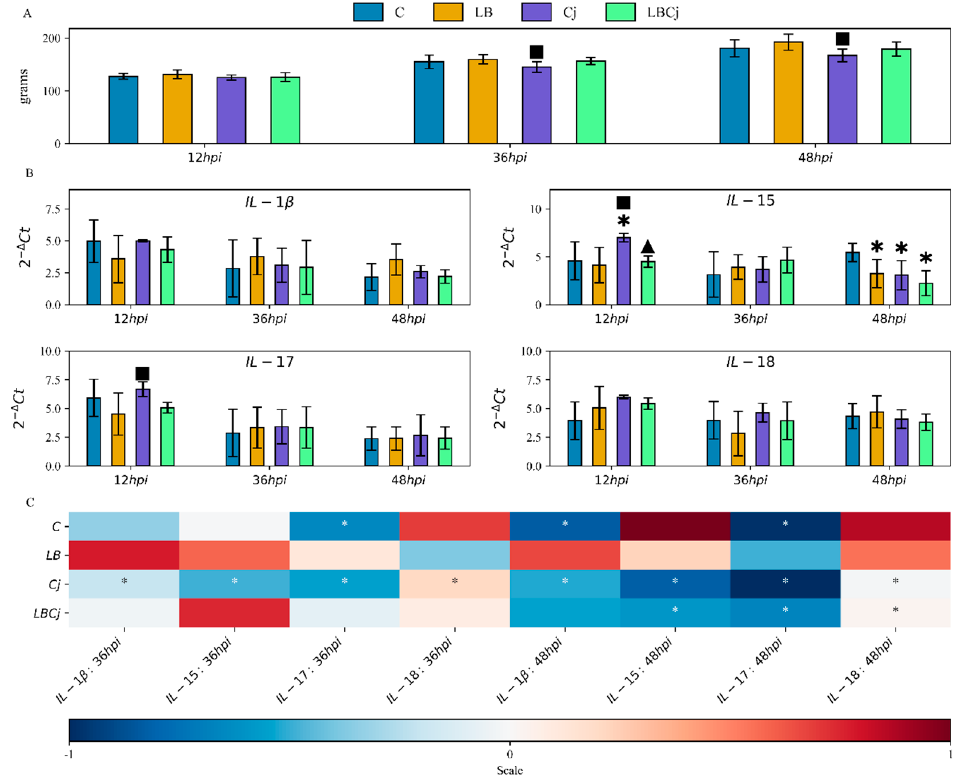
Figure 1. Effects on body weight and pro-inflammatory cytokine expression of L. fermentum and C. jejuni colonization at three different stages. (A) Average body weights of treated and untreated animals at 12, 36 and 48 hpi. (B) mRNA expression levels of caecal pro-inflammatory cytokines at three different time points. The Ct values of studied genes were normalized to a Ct value of the reference gene (GAPDH) (Delta - Δ - Ct), and calculated as 2 – Δ Ct. Values are mean ± standard error SE ( n = 9). * denotes significant differences (Tukey’s test, p < 0.05) with the control group; ■ with the L. fermentum treatment, ▲ with C. jejuni treatment. C, control group; LB, L. fermentum group; Cj, C. jejuni group; LBcj, co-exposure group; hpi, hour post-infection. (C) Heat map denoting transcriptional fold change between time points. The colour scale, − 1 (blue) to + 1 (red), denotes mRNA levels relative to the values of the control group, with white designating down-regulated genes and black designating up-regulated genes. Relative expression was calculated and expressed as 2 – ΔΔ Ct log 2 fold change. Values are mean ± SE ( n = 9). * denotes significant differences (Tukey’s test, p < 0.05). C, control group; LB, L. fermentum group; Cj, C. jejuni group; LBcj, co-exposure group; hpi, hour